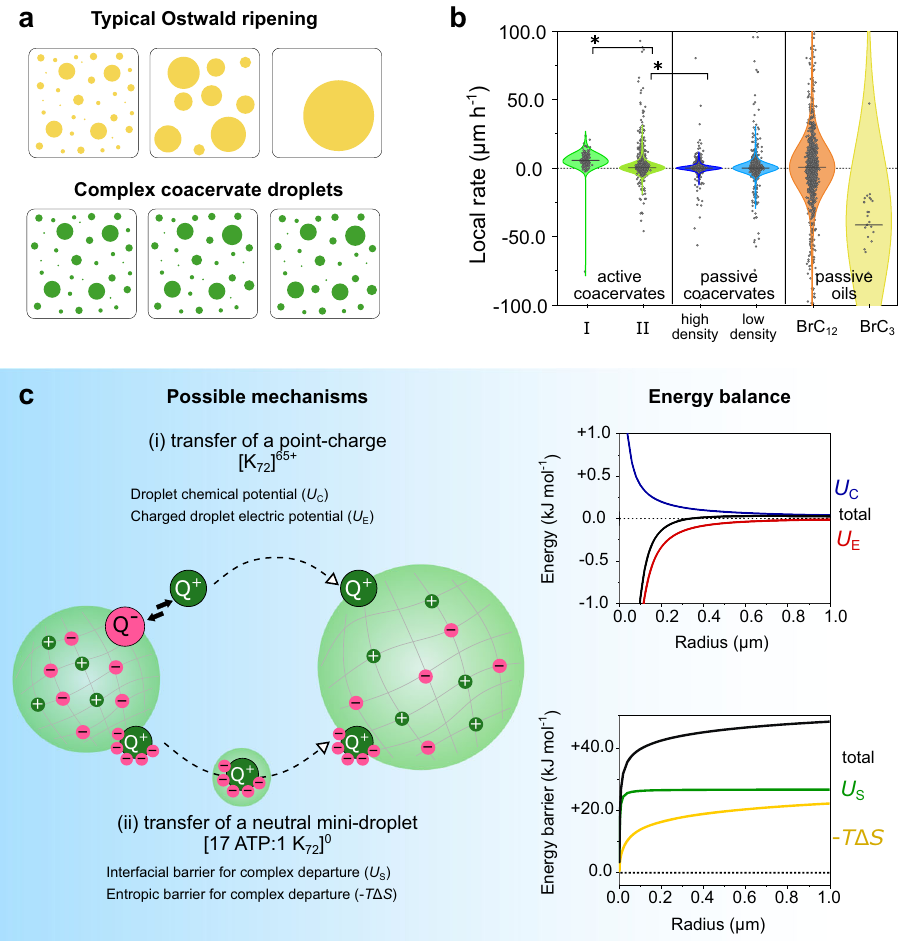
Fig. 4 Ostwald ripening in complex coacervates. a Schematics of the distinct behaviour observed for oil-based droplets and complex coacervate droplets. b The local rates can be used to quantify that distinction: active coacervates grow (phases I and II are discussed below in Fig. 5), and passive coacervates (high or low droplet densities) remain stable in size; the shrinkage of some droplets of 1-bromododecane (BrC 12 ) and 1-bromopropane (BrC 3 ) can be detected in our method as negative local rate values. Although the median growth rate for BrC 12 is positive, we see a signi fi cant fraction of droplets with a negative value, unlike the results for coacervates. Active and passive coacervates are signi fi cantly different (*) in a Mood ’ s median test ( P < 0.05). Source data are provided in Supplementary Data 1. A complete overview of experimental conditions and sample size can be found in Supplementary Table 1. c Rationalization of suppressed Ostwald ripening in complex coacervates, taking into account two possible mechanisms: in (i), free poly-electrolytes, in this case, K 72 , are transferred, leaving an oppositely charged droplet. In (ii), coarsening happens through the transfer of electroneutral complexes from small to larger droplets. This complex has an interfacial area, represented by the green droplet encasing it. Next to each mechanism, the energy balance estimation for each of the mechanisms